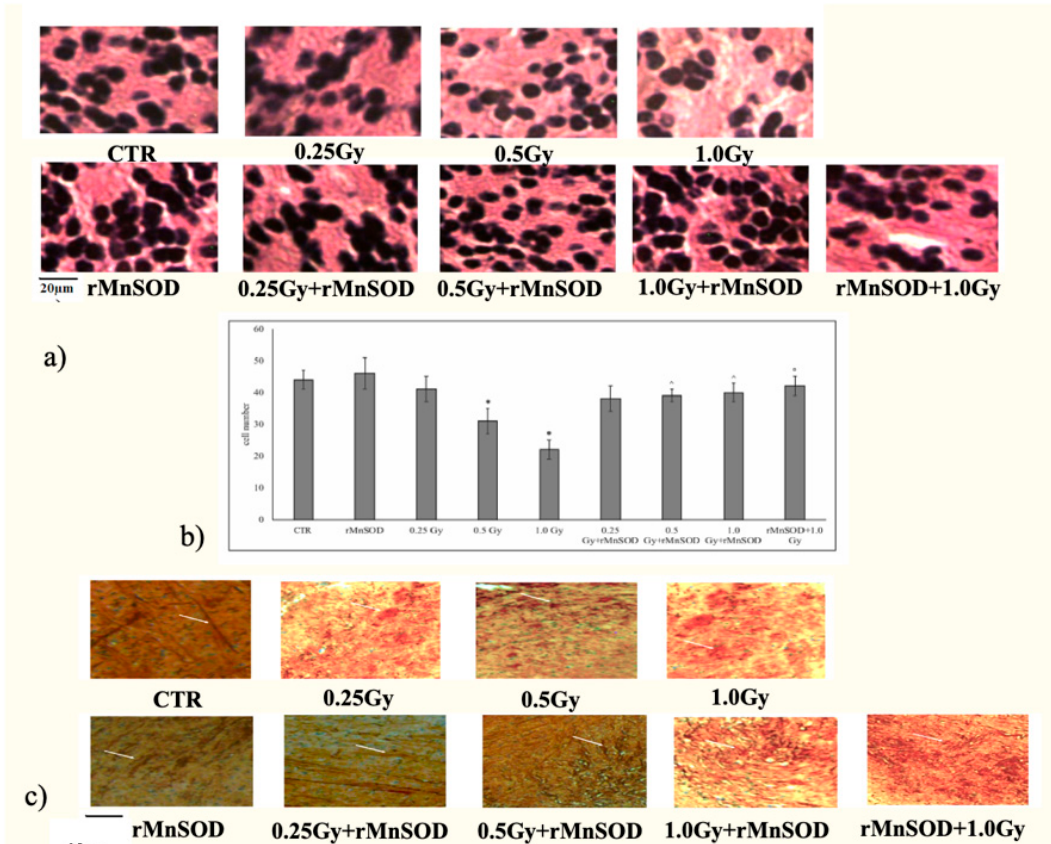
Figure 2. Midbrain nuclei and heavy neurofilament 200 kDa (NF200). ( a ) Hematoxylin-eosin-stained midbrain sections from normal mice exposed to 0.25, 0.5 and 1.0Gy radiation doses, treated in the presence or absence of rMnSOD. rMnSOD + 1.0Gy: mice pretreated with rMnSOD and exposed to 1.0 Gy, then treated with rMnSOD for 3 days. Shown images are representative of similar findings in the nuclear regions of 3 midbrains from each group of mice (40× magnification); ( b ) cell numbers were counted as described in Results. * p < 0.05 irradiated samples vs. not-irradiated control samples (CRT), ^ p < 0.05 irradiated and rMnSOD-treated samples vs. corresponding irradiated samples, ° p < 0.05 rMnSOD-pretreated and 1.0 Gy irradiated sample vs. 1.0 Gy irradiated sample; ( c ) NF200 immunohistochemical staining. Normal mice were exposed to 0.25, 0.5 and 1.0 Gy radiation doses, with or without rMnSOD administration. rMnSOD + 1.0Gy: mice pretreated with rMnSOD for 3 days before 1.0 Gy radiation. Images are representative of similar images showing heavy neurofilaments in 3 midbrains from each group of mice (20 × magnification). Arrows indicate normal neurofilaments (CTR), accumulation of labeling in round areas with reduction of length and thickness in neurofilaments (irradiated samples), and the presence of normal neurofilaments in rMnSOD-treated samples, thus demonstrating its radioprotective e ff